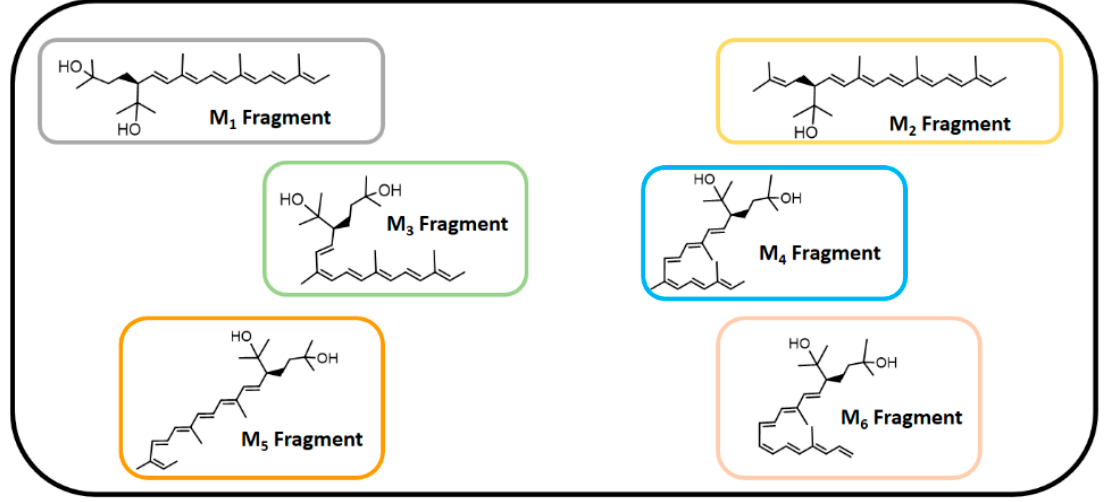
Figure 8. Carotenoids structure fragments used in cholinesterase docking assays.